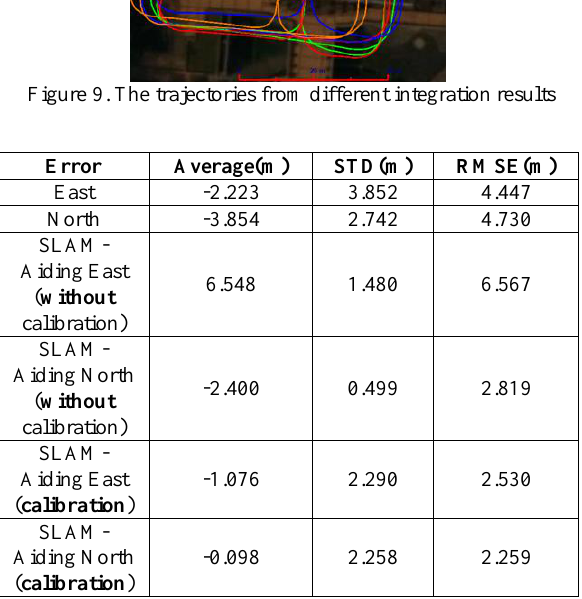
Table 6. Evaluation of different integration